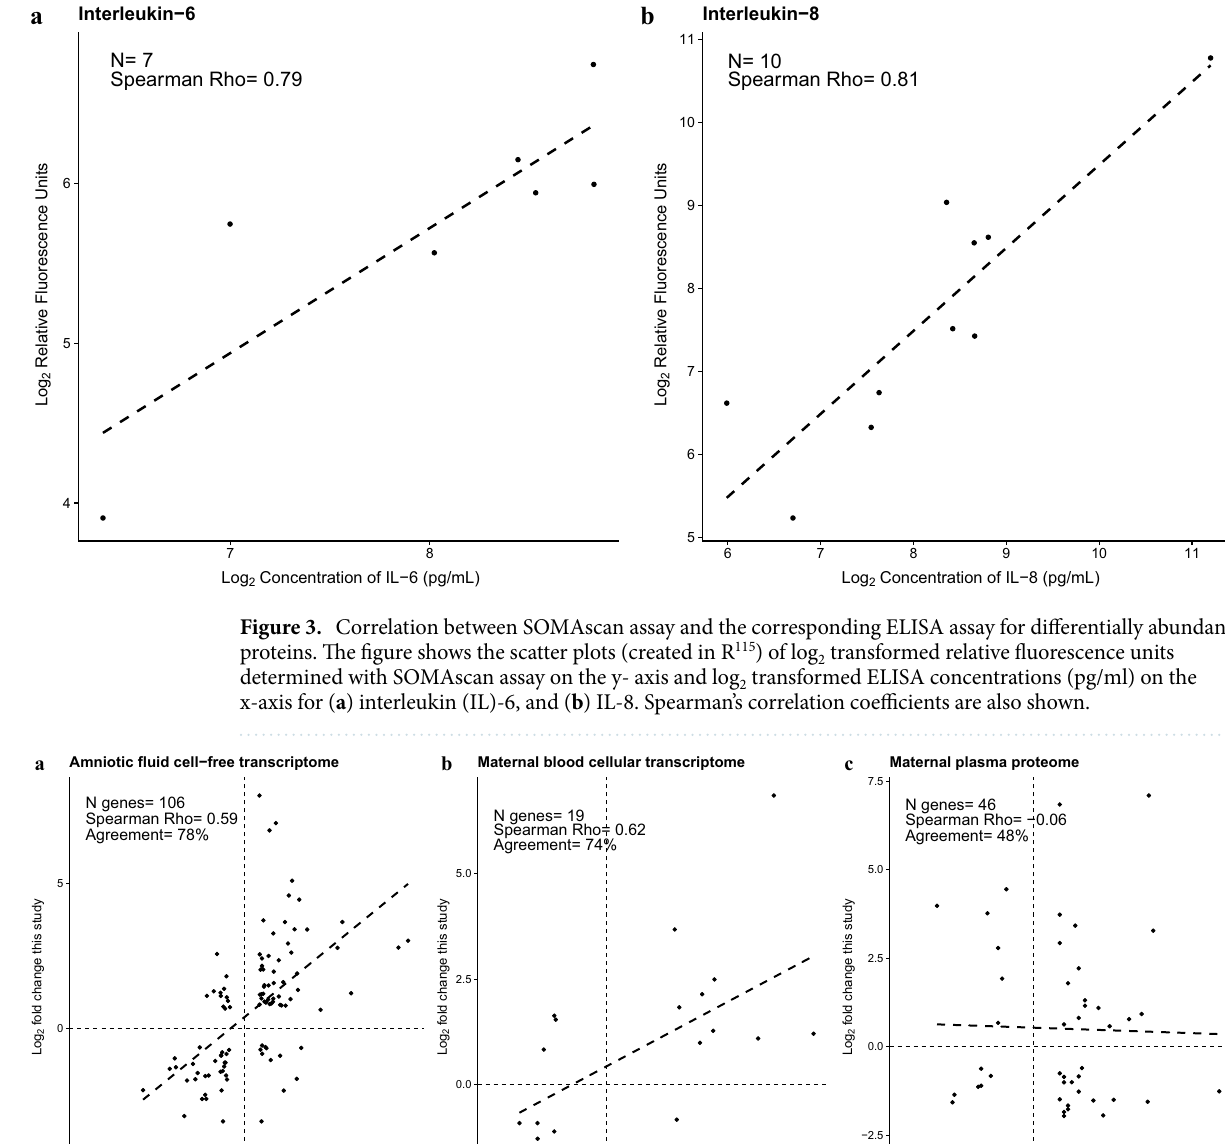
N genes= 19 Spearman Rho= 0.62 Agreement= 74%